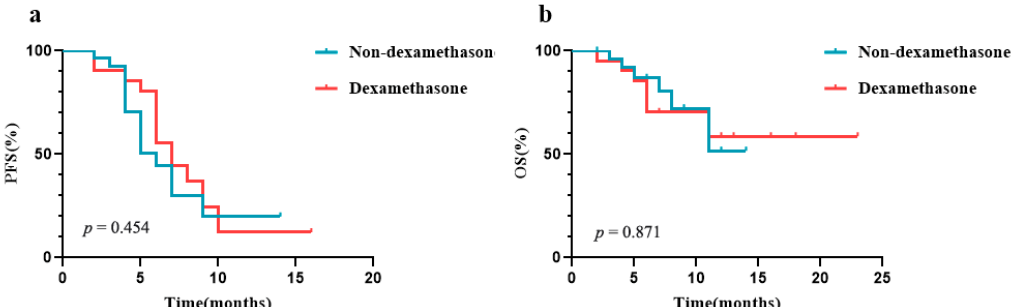
Figure 2. The PFS and OS for patients treated with dexamethasone in the ICIs group. ( a ) The PFS